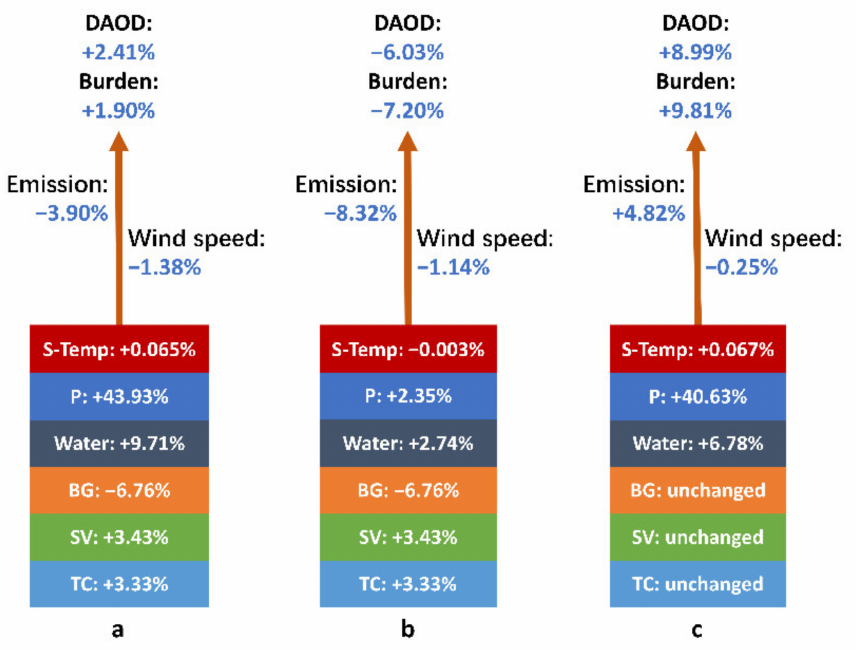
Figure 3. The three scenarios of spring sand-dust event variation during the period of 2000–2015 over northern China based on AVHRR-BATS land cover data. ( a ) Scenario A1: The sand-dust events are affected by climate change and vegetation cover changes; ( b ) scenario A2: The sand-dust events are affected only by vegetation cover changes; ( c ) scenario A3: The sand-dust events are affected only by climate change. S-Temp: Near-surface temperature from RegCM simulation; P: Precipitation from RegCM simulation; BG, SV, and TC: Bare ground, short vegetation, and tree canopy, respectively, derived from vcf5kyrv001 data